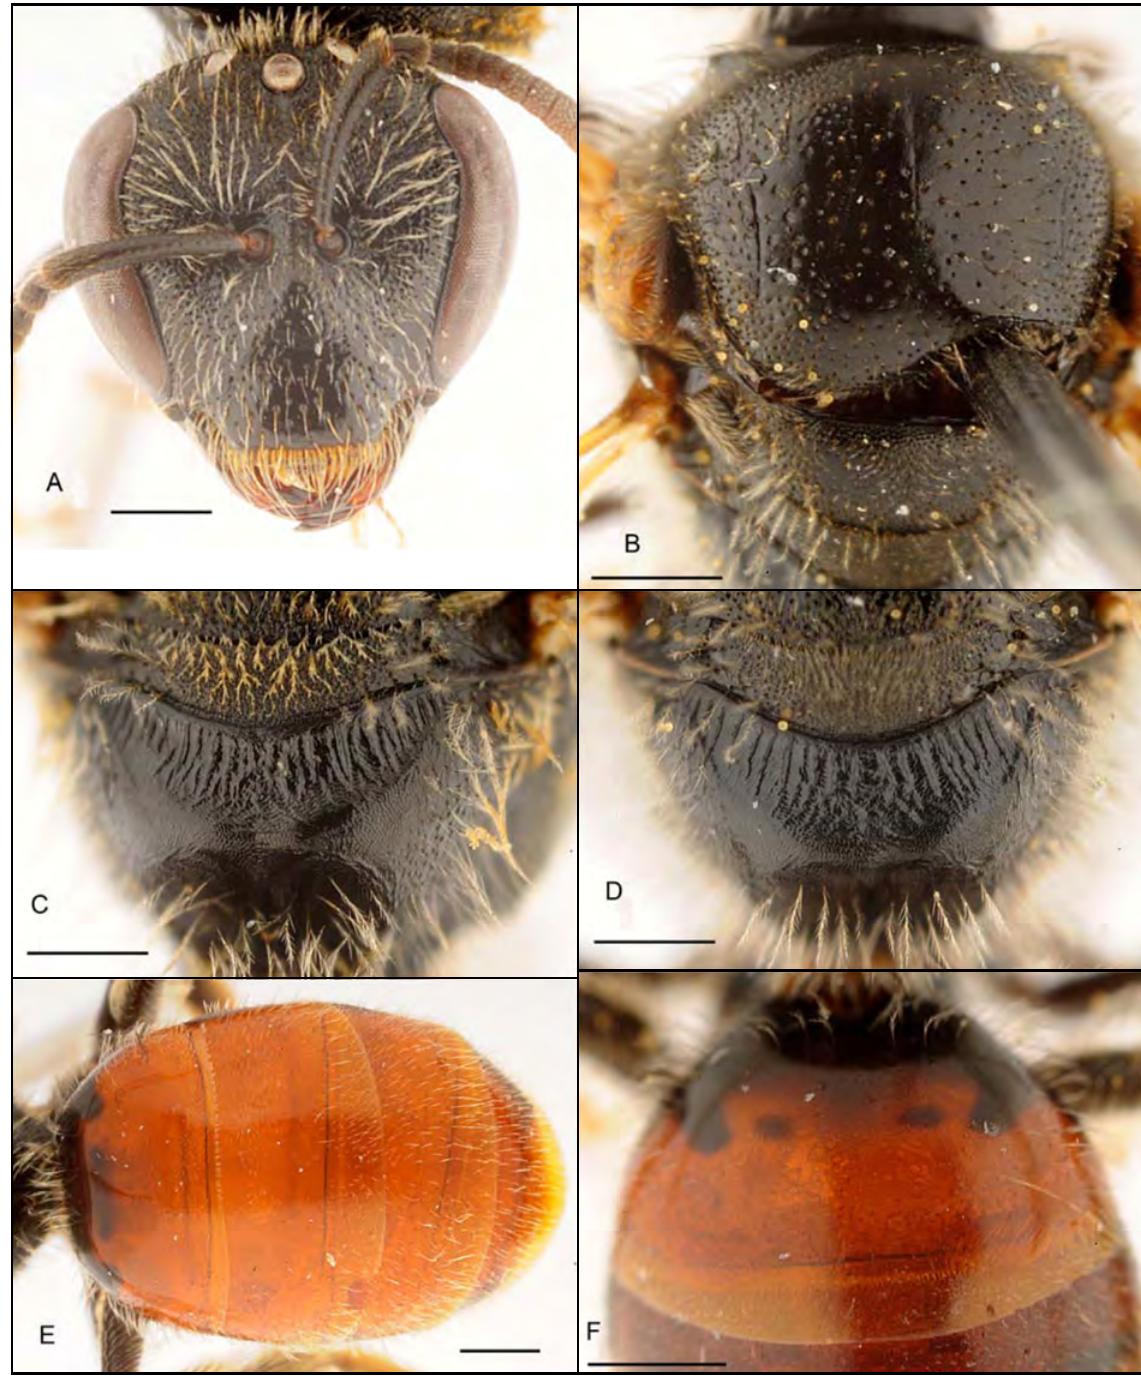
Fig. 9. Lasioglossum ( Capalictus ) timmermanni sp. nov. , ♀. A . Head. B . Mesoscutum and scutellum. C . Propodeum. D . Metanotum. E . Metasoma. F . First tergum. Scale line = 0,5